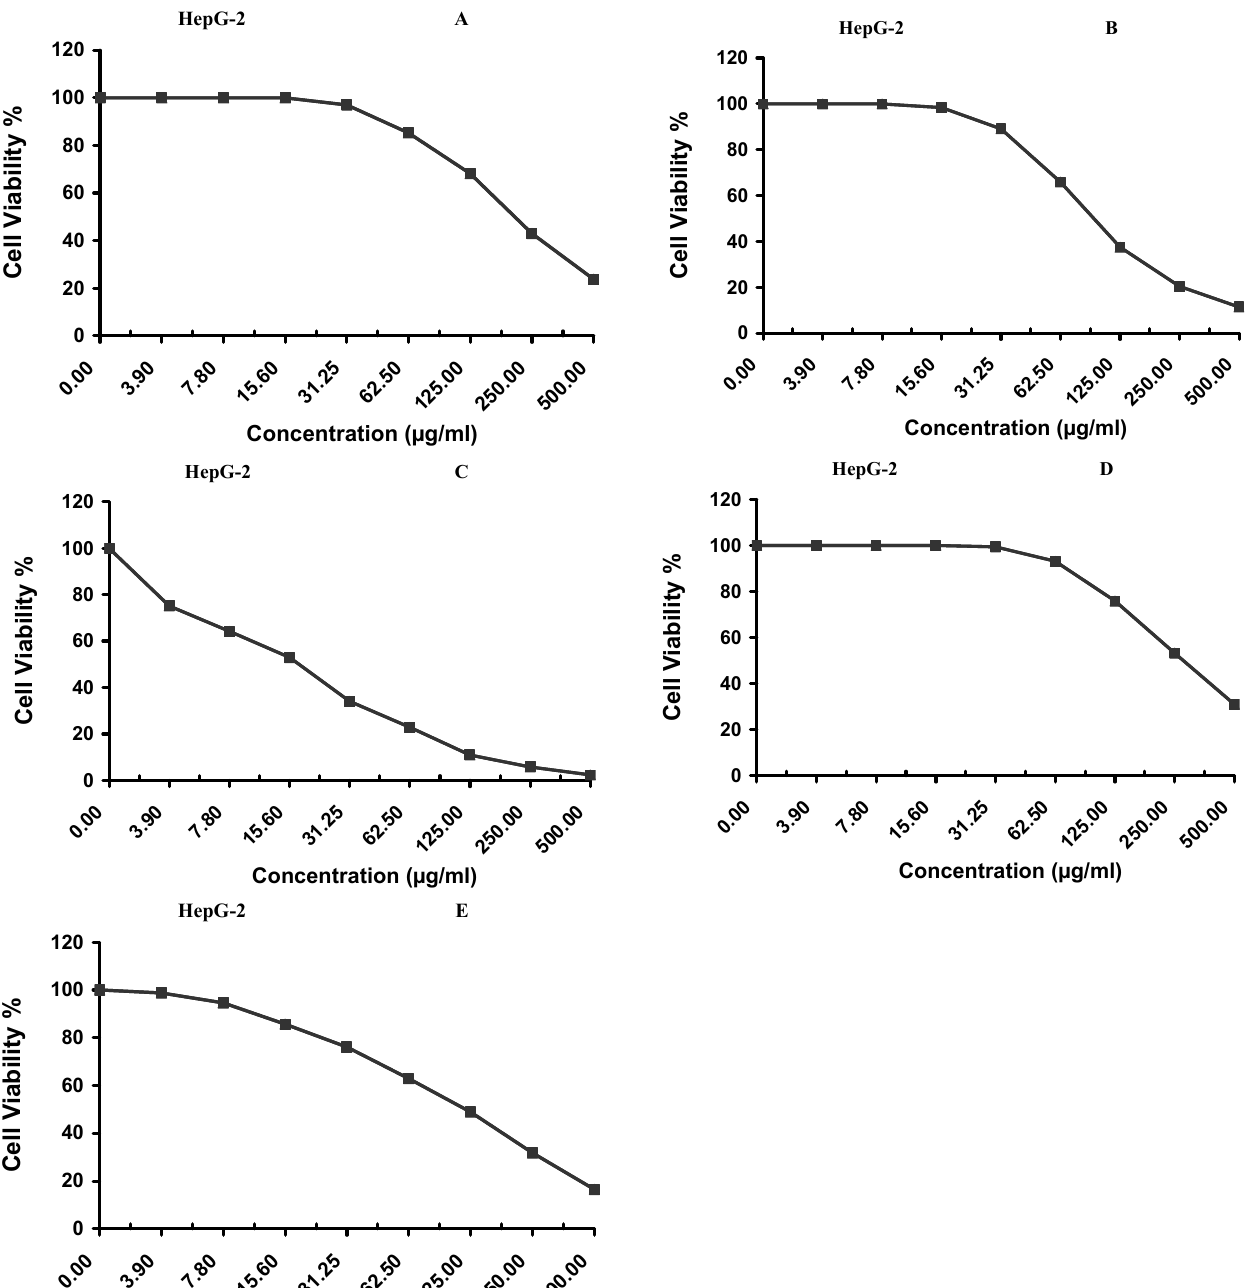
PLGA-Cf-F 2 NPs and ( D ) the PLGA-Cf-F 3 NPs. Finally, graph ( E ) is for the free coffee extract.